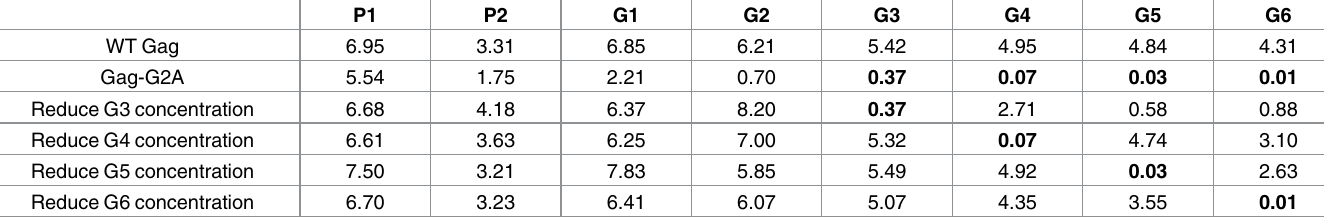
Table 6. Compare the concentrations of higher-order polymers 1